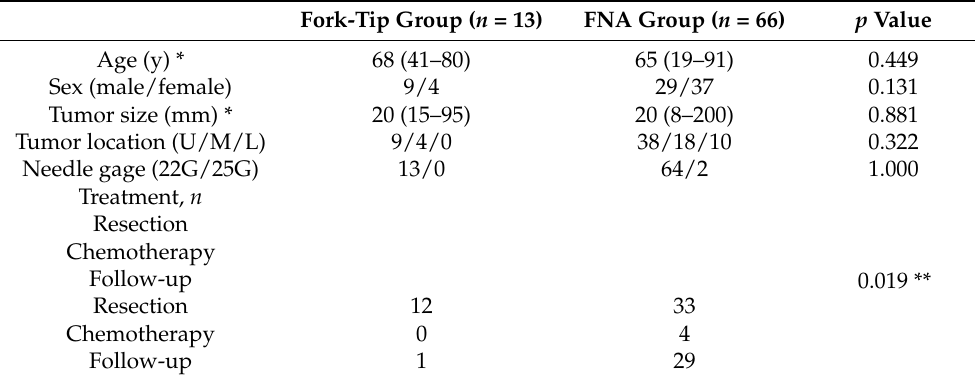
Table 1. Patient characteristics and features of subepithelial lesions.